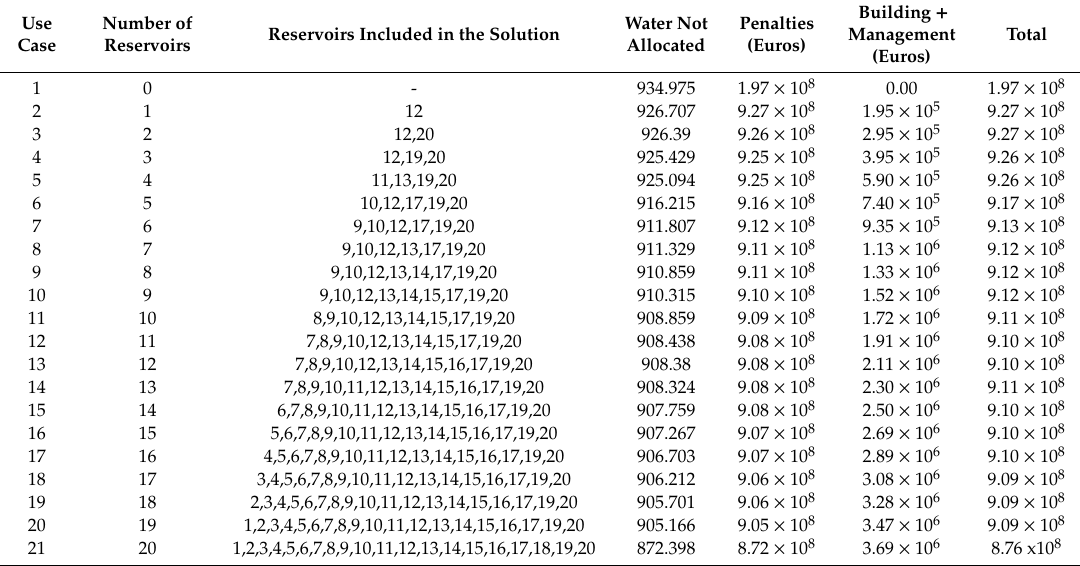
Table 7. Summary of the results of including a di ff erent number of reservoirs in the MILP model. Use